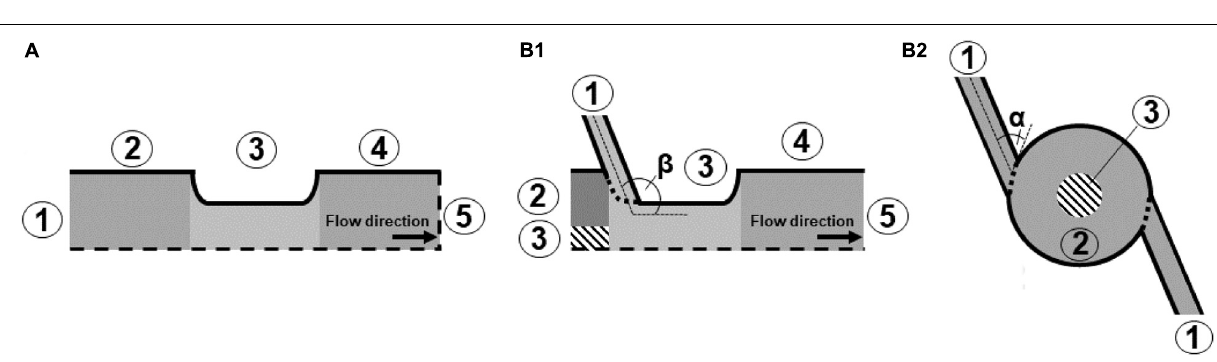
FIGURE 2 | Schematic drawing of the simulated domain for co-linear (A) and vortex (B1) configurations, and bottom view of the vortex treatment chamber (B2) . Further depicted are the varied inlet angles, α and β , as well as the boundaries (1–5). The values of the boundaries are summarized in Table 2 . The dashed lines indicate symmetry